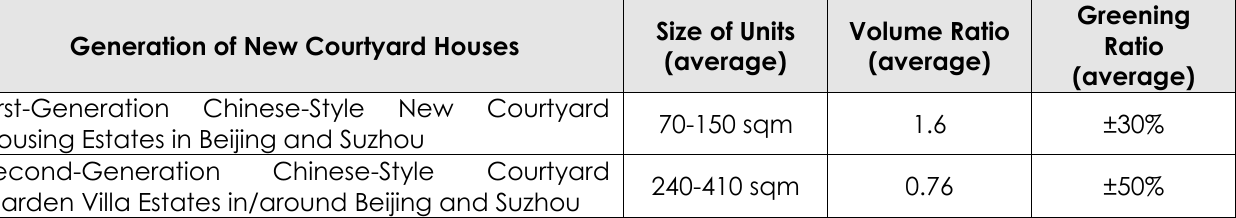
Table 4. Comparison of the Chinese-style first-generation new courtyard housing and second-generation courtyard garden villa estates built in China in the